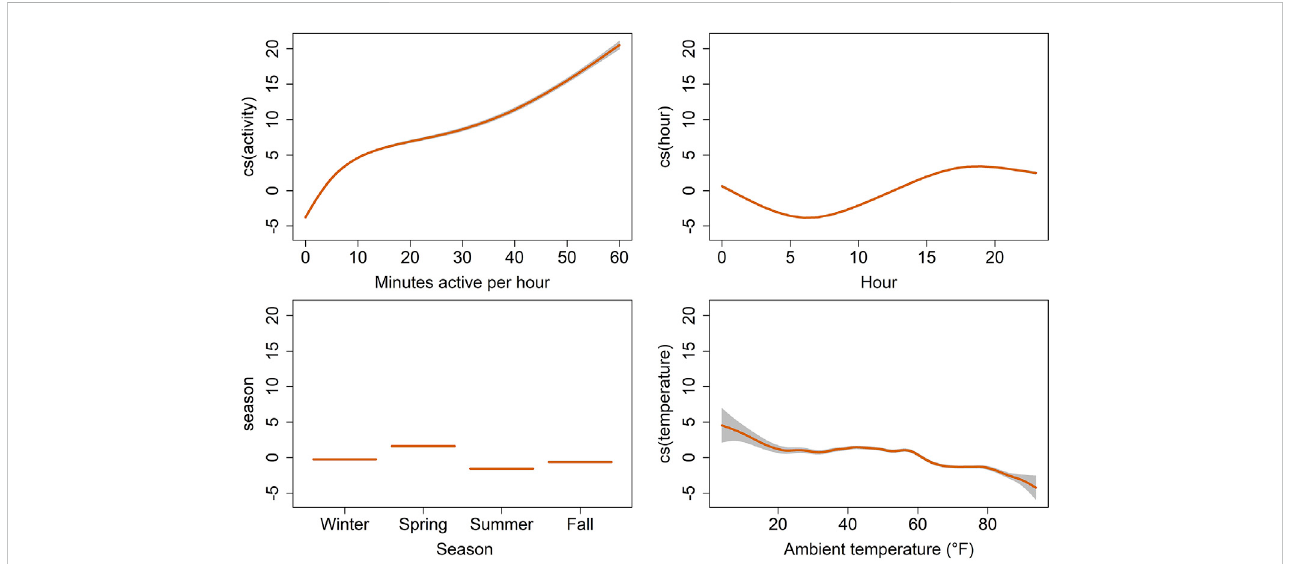
FIGURE 6 Termplot of the best fi t generalized additive model for location, scale, and shape (GAMLSS), showing on the y-axis the partial effects of selected explanatory variables on the hourly average of heart rate (bpm) for six captive scimitar-horned oryx. Heart rate estimates are represented by the trend lines [cubic spline (cs) smooth predictors for activity, hour and ambient temperature and linear predictors for season]. The gray shaded areas correspond to the estimates ’ standard errors. Individual scimitar-horned oryx were included as random effects and individual variation in heart rate was con fi rmed in a null